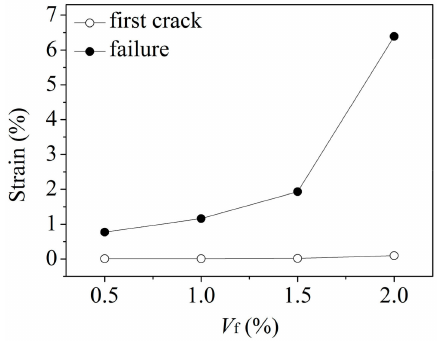
Figure 10. Influence of V f on tensile